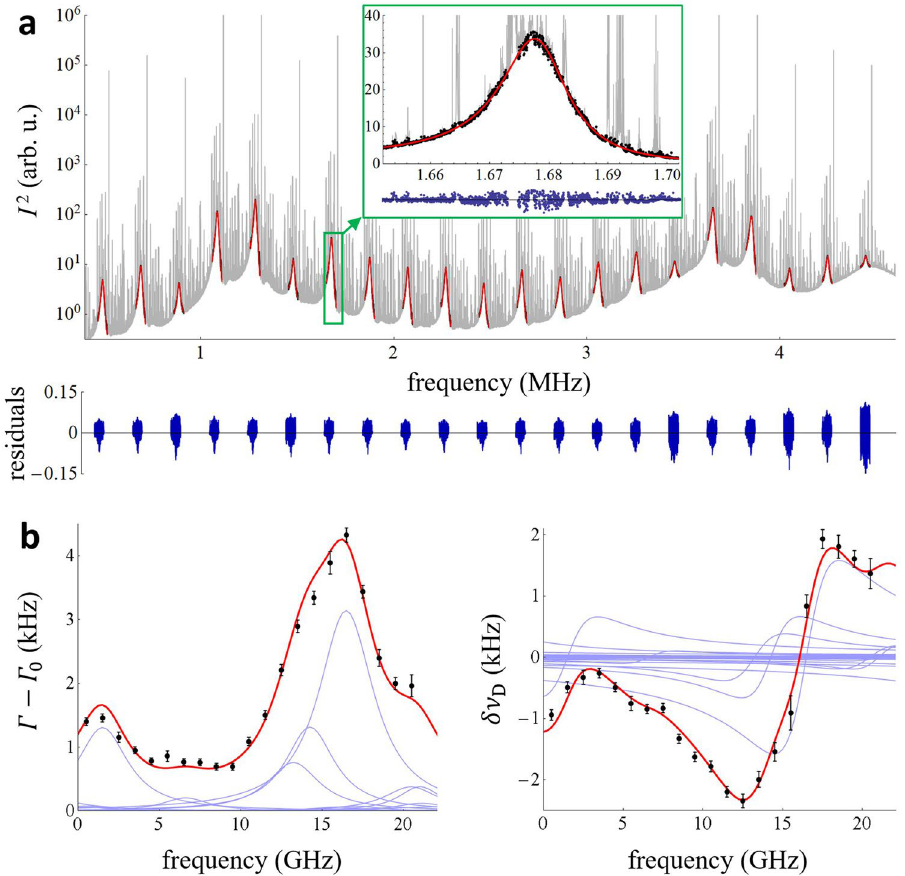
Figure 4. Molecular spectra measured by incoherently driven cavity excitation. ( a ) Fourier spectrum of the down-converted probe comb continuously transmitted through the cavity and ring-down events excited by phase noise of the probe comb (gray line). An average of 2000 spectra of consecutive signals each 50 ms in duration is shown. In the inset, a zoom of one cavity mode is shown. Black points are the data selected for mode shape fitting and the fitted mode shapes are shown as red lines. Below, ratios of the fit residuals to the mode peaks are shown as blue lines. ( b ) Absorption (left plot) and dispersion (right plot) spectra of methane (black points) retrieved from the measured cavity mode widths (HWHM) and positions. An offset of 191,605.977 GHz has been subtracted from the optical frequency axis, and the error bars correspond to the three times the measured ensemble standard deviation at each spectrum detuning. The reference shape of the methane spectrum from HITRAN2016 is shown as a red line with individual transitions shown as blue lines. The overall intensity of the reference spectrum was fitted simultaneously to the absorption and dispersion experimental spectra. The fitted absorption spectrum background of 6.10(5) kHz, corresponding to the empty cavity losses was subtracted from the plot. The linear background of the fitted dispersion spectrum, which represents a mismatch between the average cavity FSR and the probe comb f r , was also subtracted from the